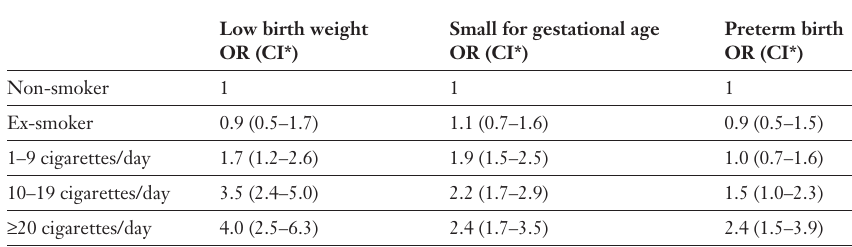
Proportions of in- fants with low birth weight, small weight for gestational age or born prematurely attributable to mater- nal smoking during pregnancy.